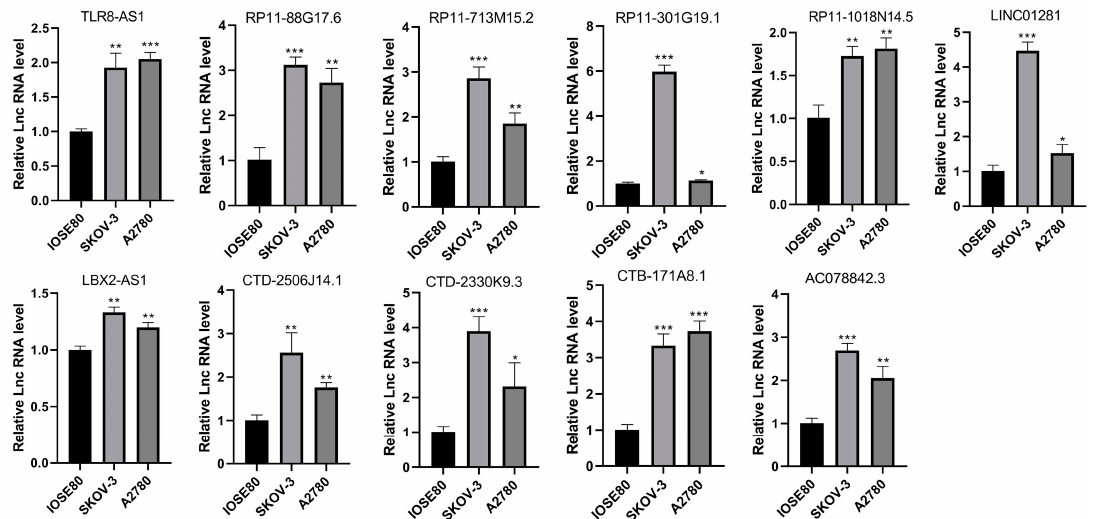
Figure 11. Expression levels of long non-coding RNAs (lncRNAs) in normal and ovarian cancer cell lines using qRT-PCR experiments. * p < 0.05; ** p < 0.01; *** p <